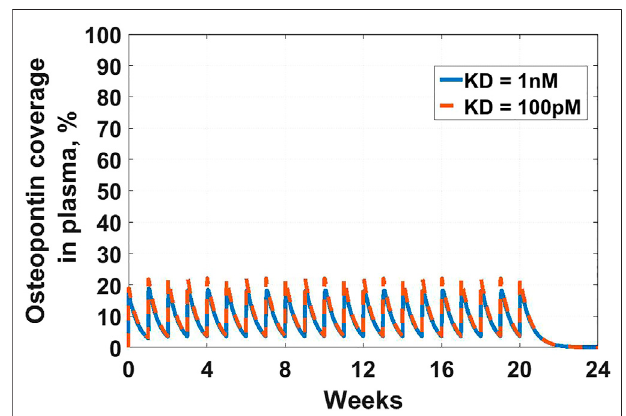
FIGURE 2 | Osteopontin coverage in plasma: Shows the projected neutralization of osteopontin after mAb administration as described in Osteopontin Example . Simulated dose is300 mgSCQ1W,withtwoantibody af fi nities – K D of 1 nM (solid blue line) and 100 pM (dashed orange line). Even peak projected neutralization is only 20%, which is unlikely to result in meaningful